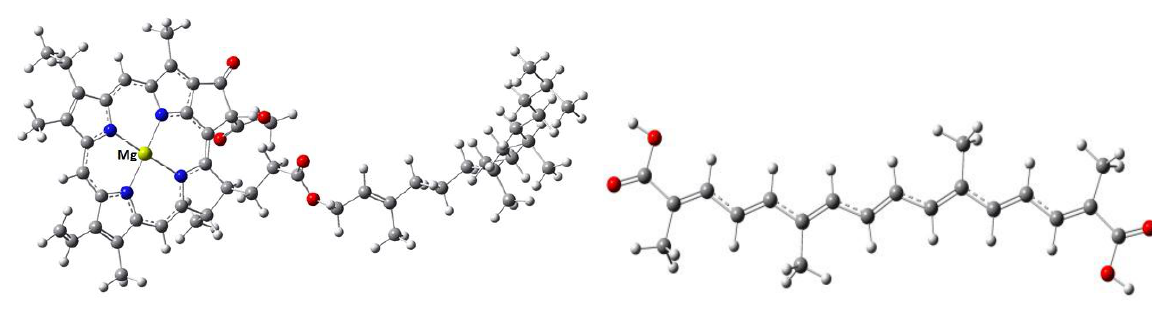
Figure 1: Chemical structures of Chlorophyll a (1) and Crocin (2) .